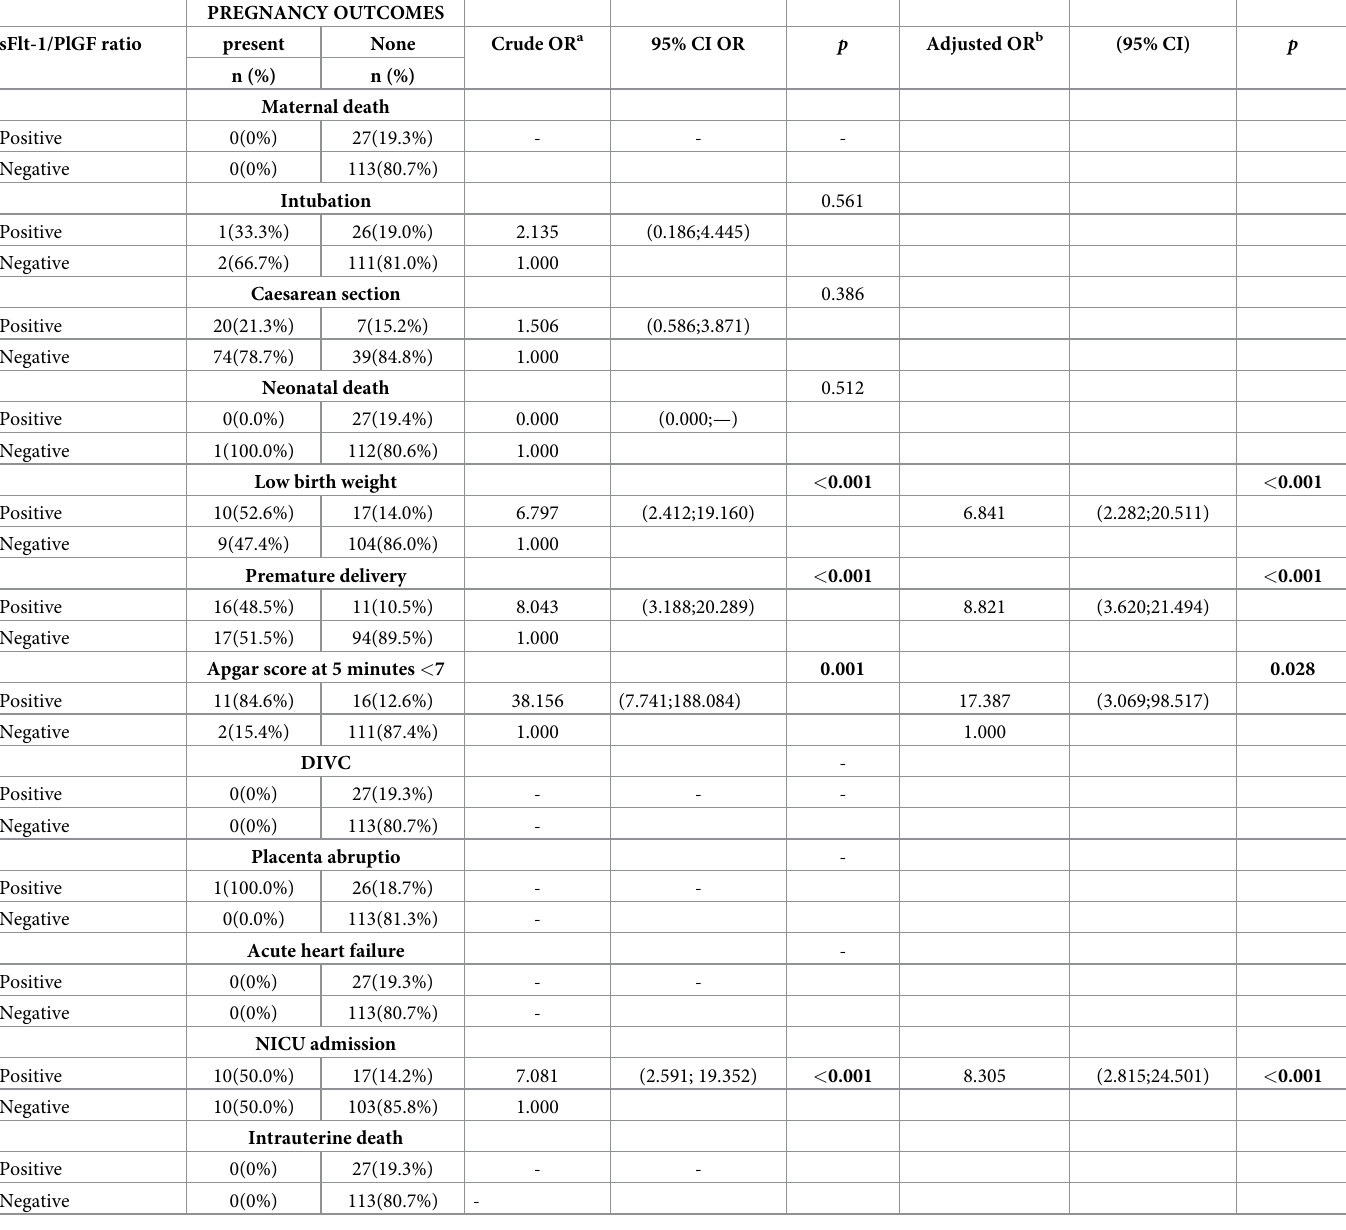
a Crude odd ratio using simple logistic regression.